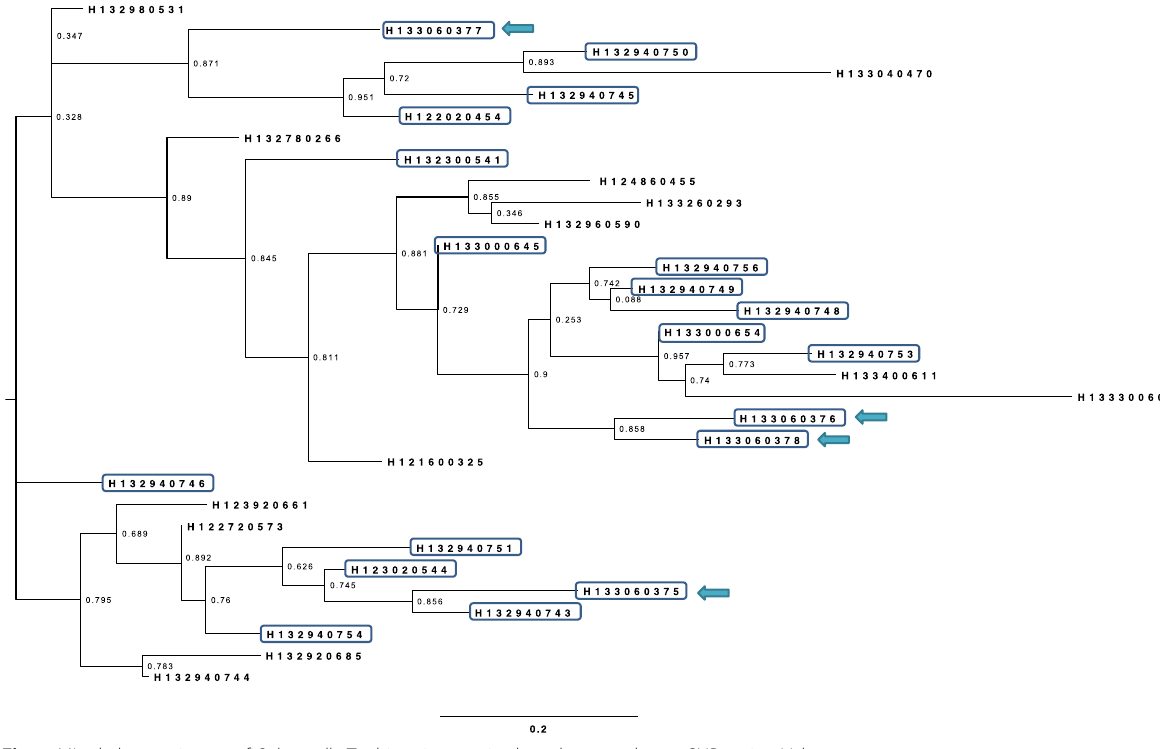
Fig. 5 ML phylogenetic tree of Salmonella Typhimurium strains based on prophages SNPs using